Question: Briefly state, in one sentence, what is plotted here.
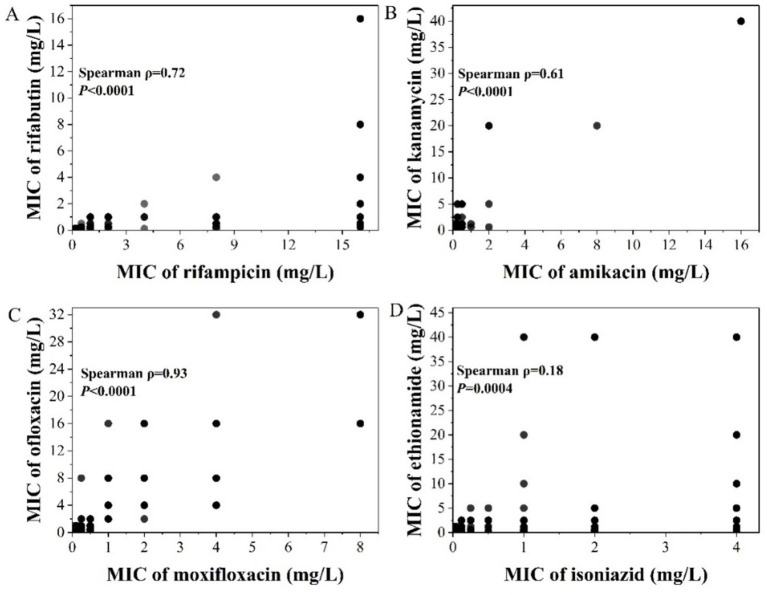
Answer: The correlations of MIC values between (A) rifampicin and rifabutin, (B) amikacin and kanamycin, (C) moxifloxacin and ofloxacin, (D) isoniazid and ethionamide.